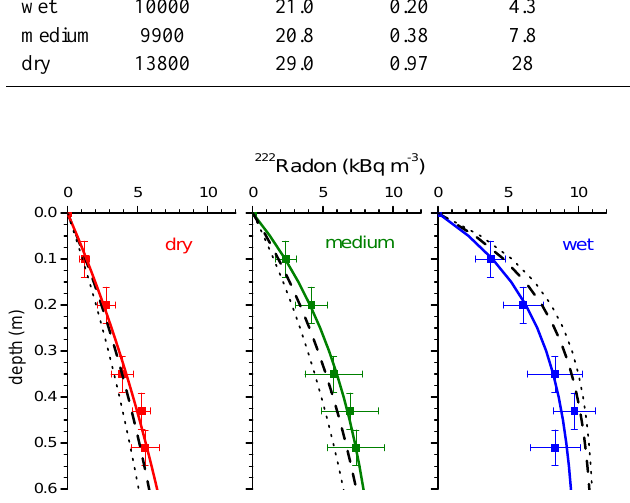
Figure 1. Mean vertical profiles of the 222 Rn activity concentra- tions measured in a soil in Heidelberg (IUP) averaged over dry (mean θ w = 0.124), medium dry (mean θ w = 0.199) and wet (mean θ w = 0.311) soil moisture conditions in 2011–2012. The coloured lines are fitted curves through the data according to Eq. (7). The dashed lines are activity concentration profiles calculated with dif- fusivity estimated with the Millington and Quirk (1960) model, while dotted lines are respective profiles calculated with the dif- fusivity model from Rogers and Nielson (1991). Both estimates use the measured soil porosity ( θ p = 0.368), mean θ w and soil temper- ature during the measurements, as well as a mean source strength Q = 23.6mBqm − 3 s − 1 , i.e. the mean from all measured profiles estimated according to Eq. (7a) (i.e. mean of Table 1, third column).